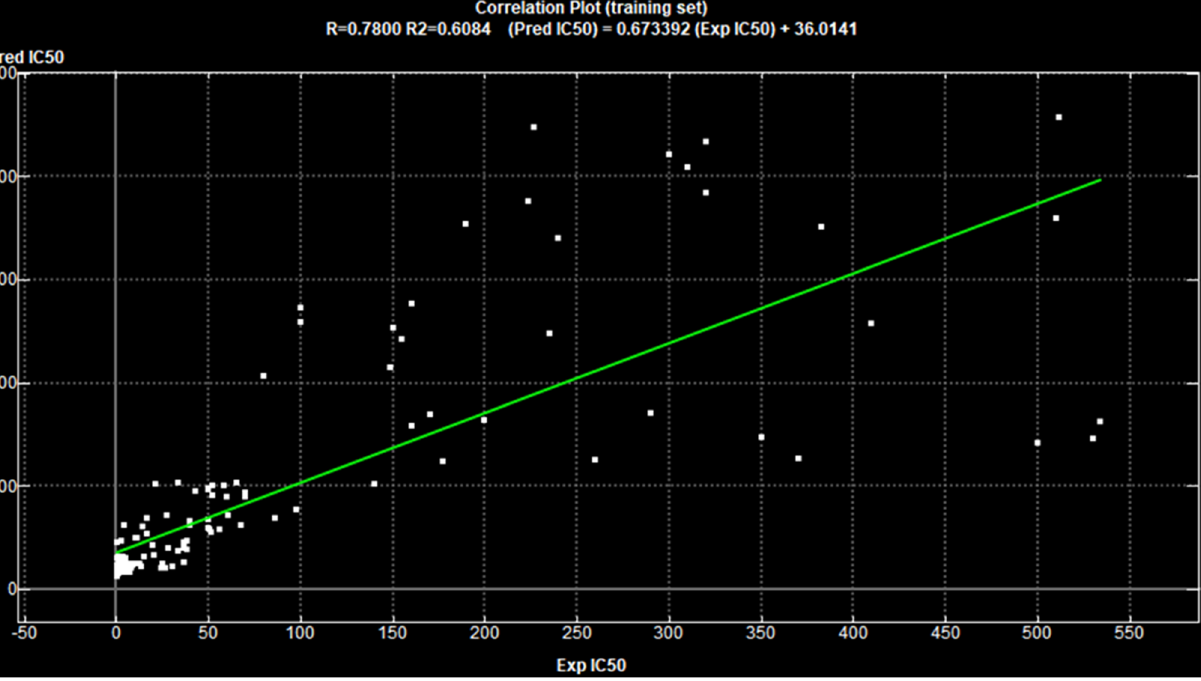
Figure 4. Correlation plot of the training set ( t1 – t150 ) showing R 2 value = 0.6084.